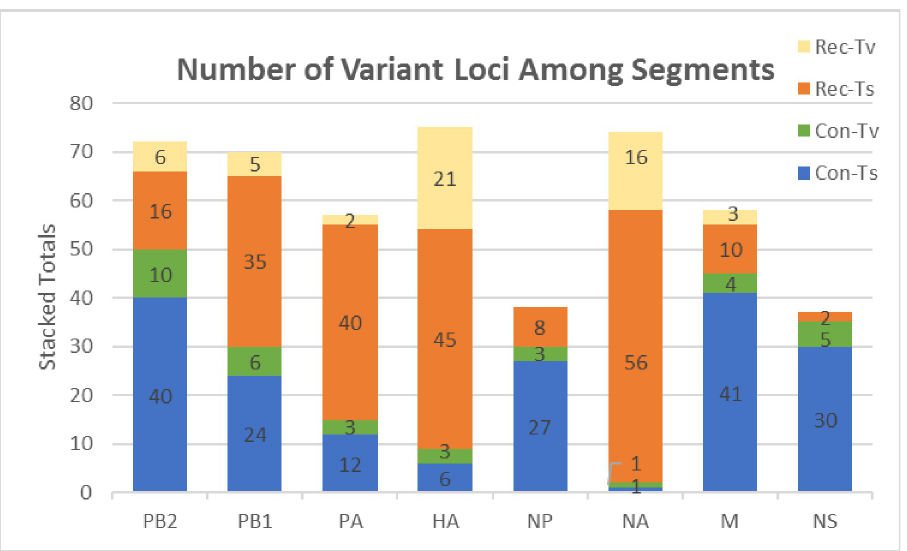
Fig 2. Number of variant loci among segments. The number of loci with variants present at levels greater than 5% in NGS data for ORFs in each segment are graphed. The loci are labelled as reciprocal or convergent as described in the text. Loci are further divided as either transitions (Ts) or transversions